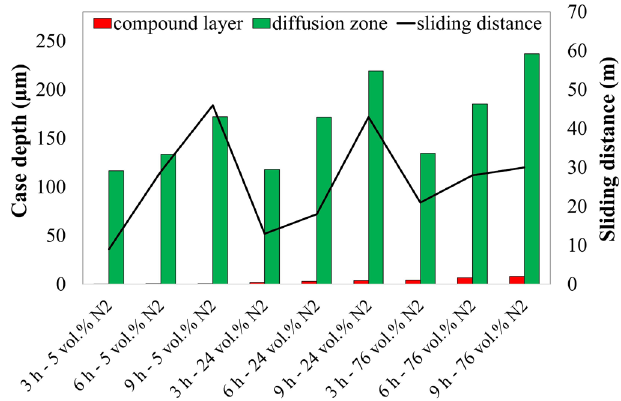
Figure 8. Compilation of results from case depth and sliding distance before microcracks formation or delamination of the surface